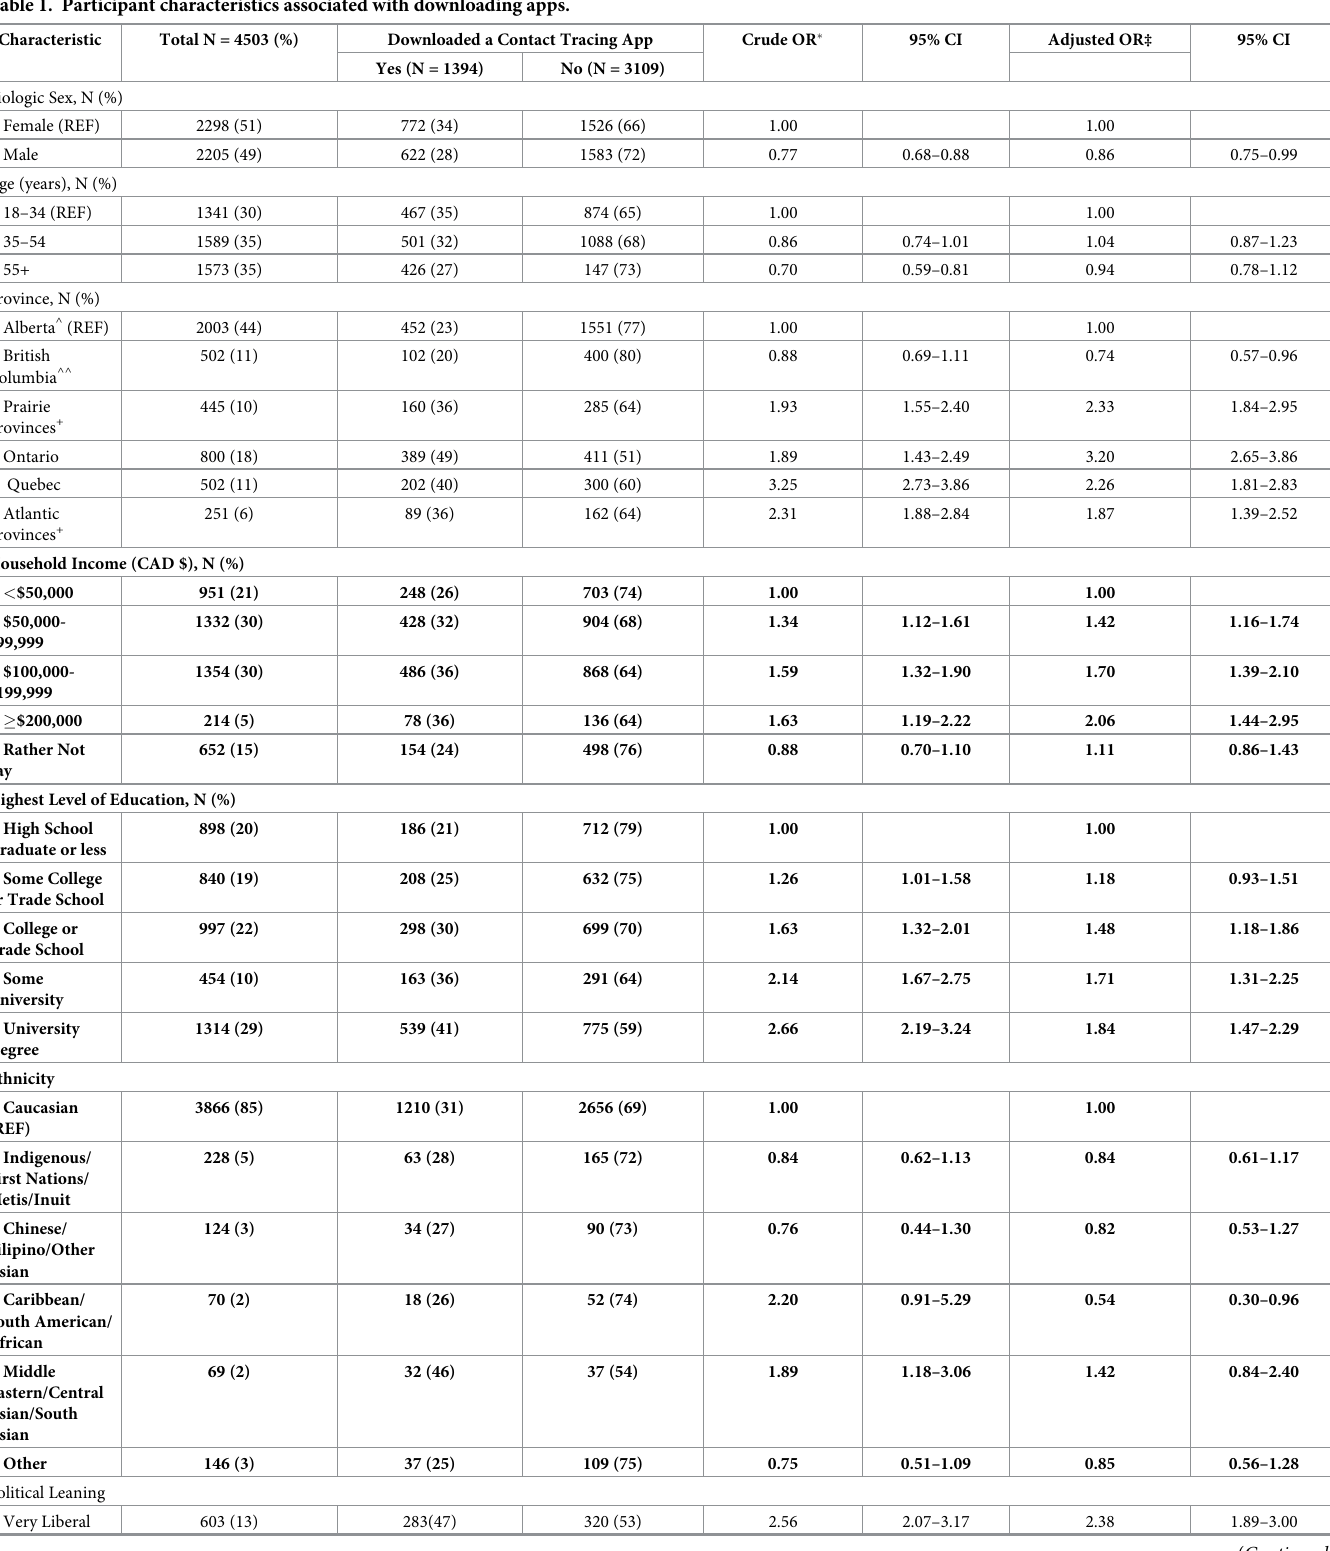
Table 1. Participant characteristics associated with downloading